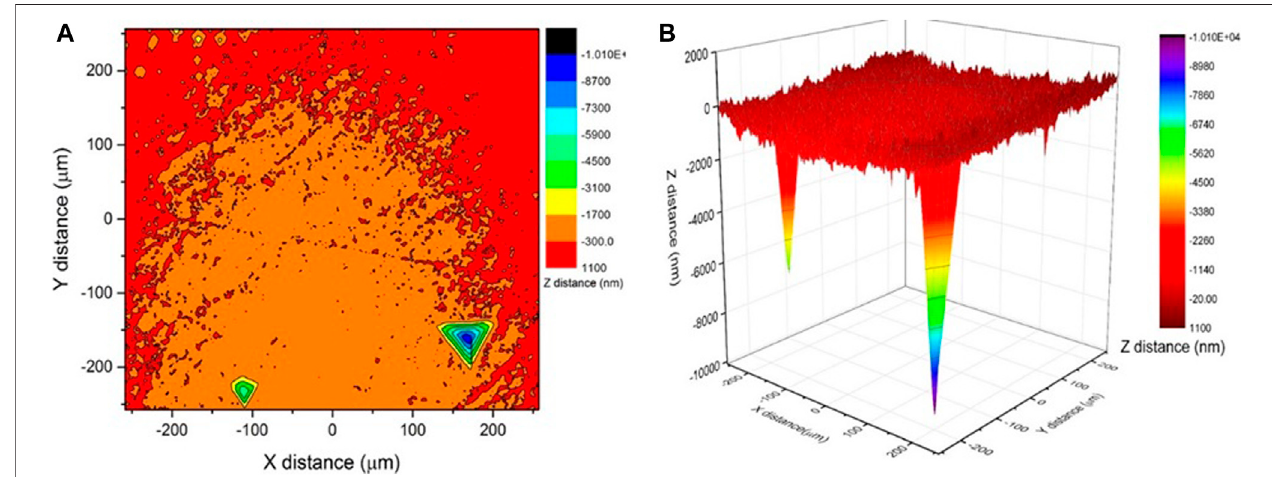
FIGURE 8 | Survey scanning results on the polished sample after indentation.